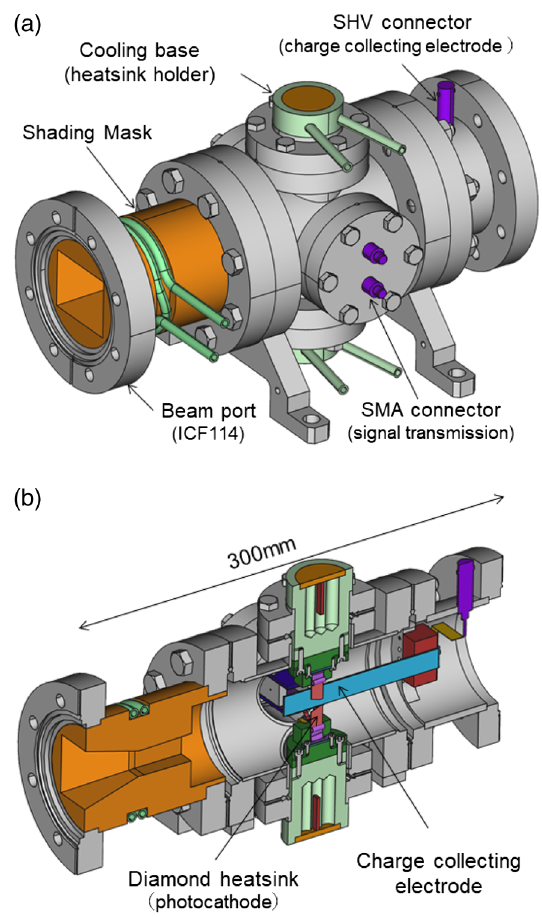
FIG. 15. Overall structure of this monitor, (a) a view of the external configuration and (b) a view of the internal configuration along a vertical cross